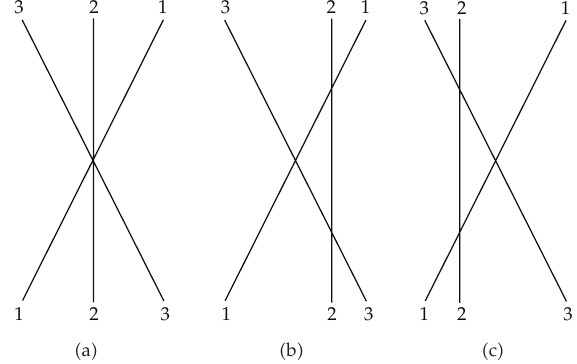
Figure 3: Tree level diagrams for three-body scattering 3 −→ 3.